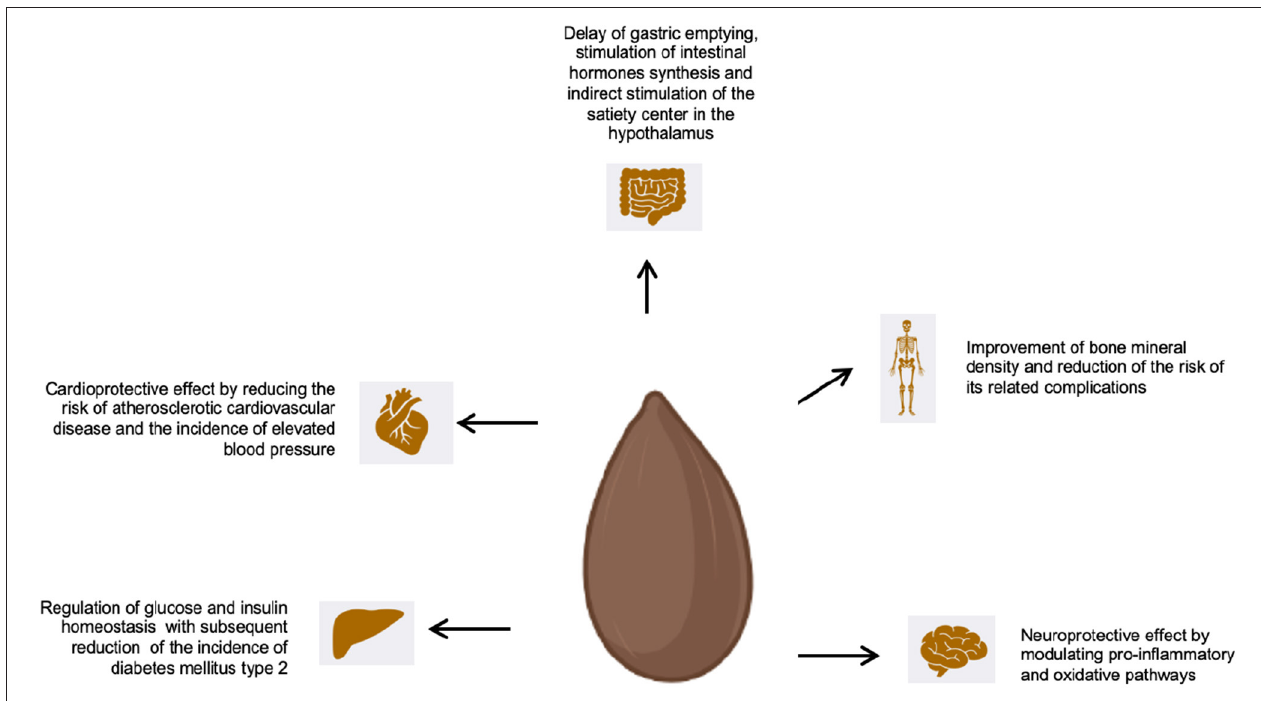
FIGURE 2 | Effect of WG on health and